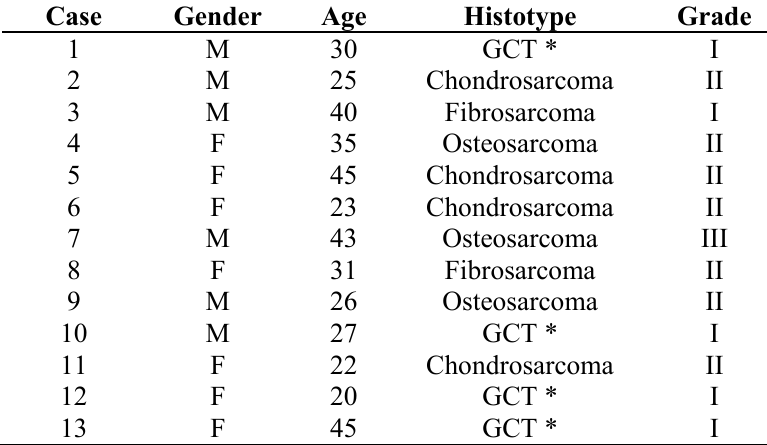
Table 1. Clinical pathological features of bone biopsies.